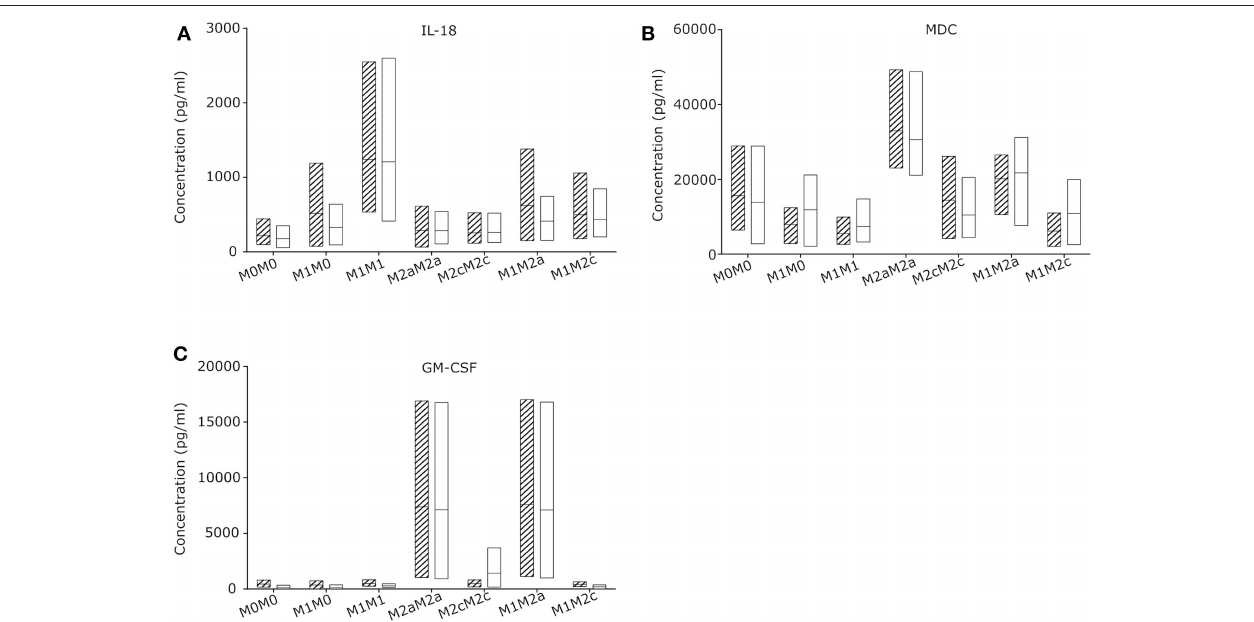
FIGURE 3 | CGD and control macrophage derived cytokines/chemokines upon re-priming (72h) of M1 primed (24h) macrophages. Macrophages of CGD patients and of controls were left unstimulated (24 + 72h) (M0M0), or were primed (24h), followed by withdrawal of stimulus (M1M0), or by re-priming for 72h (M1M1; M2aM2a; M2cM2c; M1M2a; M1M2c). Released cytokines/chemokines of (A) IL-18, (B) MDC and (C) GM-CSF were quantified after 24 + 72h. N = 3, empty = control, striped = CGD.